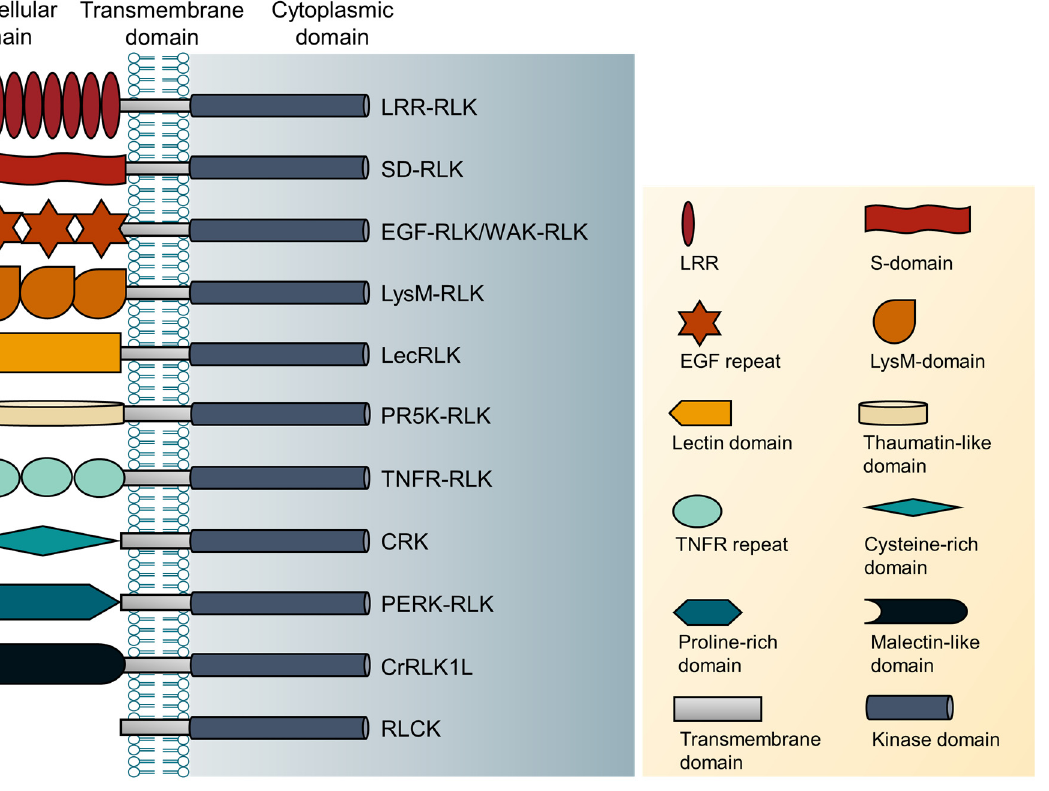
Figure 2. Protein domain architectures of 11 selected RLKs. Table 1. Classification of RLKs according to their extracellular domain.